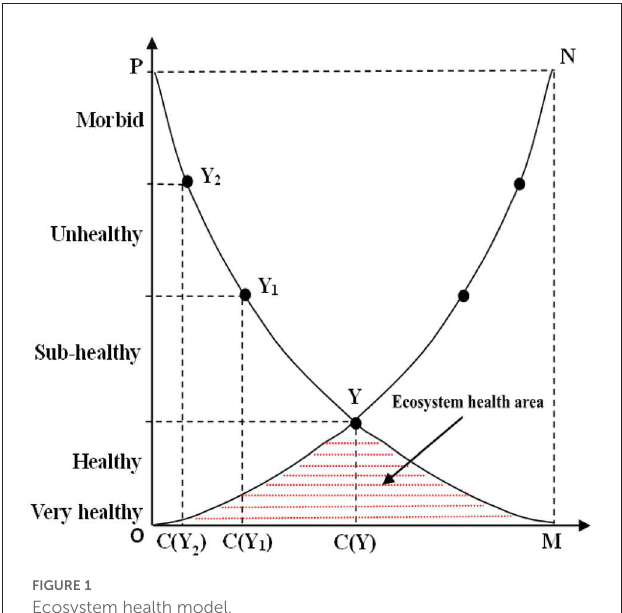
FIGURE1 Ecosystem health model.